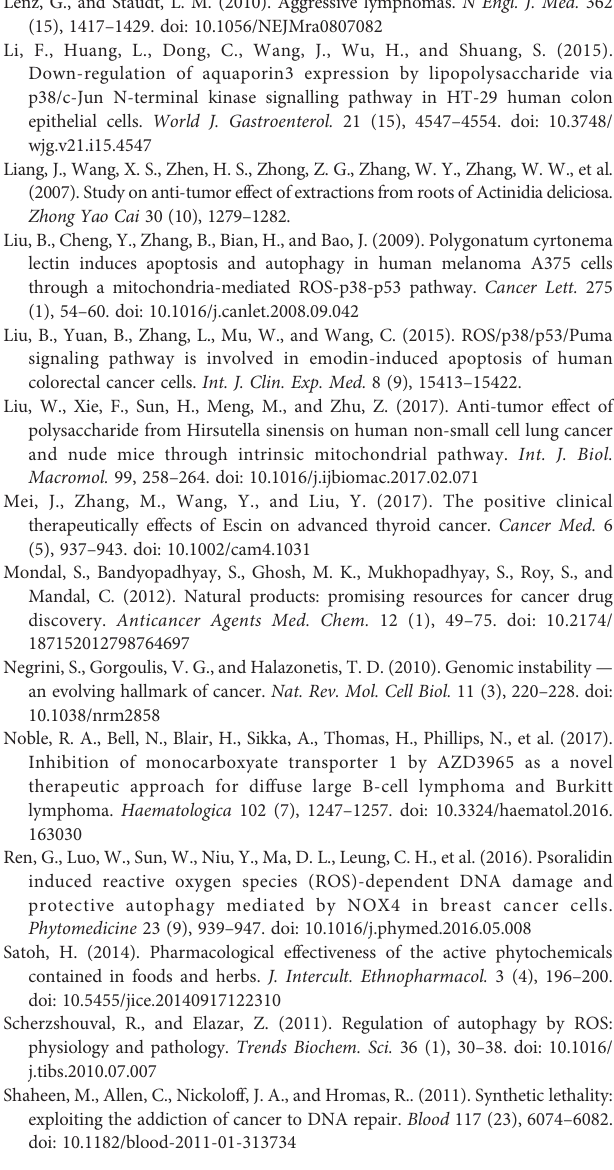
FIGURE S3 | Inhibition of p38 activation rescued cell viability under treatment of TEOA. SB203580 (10 m M) was pretreatment for 1 h and cotreatment with TEOA for 12 h, cell viability was determined by CCK8 assay. * P <0.05. FIGURE S4 | TEOA exhibited no synergistic activity with vindesine or cyclophosphamide in normal cells. TEOA was cotreatment with vindesine or cyclophosphamide for 12 h and cell viability was measured by the CCK-8